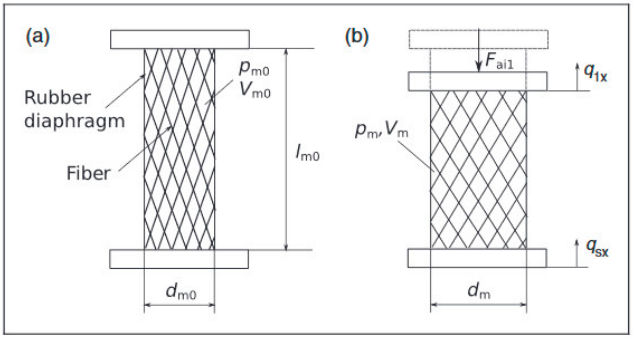
Figure 8. ( a ) The pneumatic muscle at the nominal length and ( b ) After contraction [55].